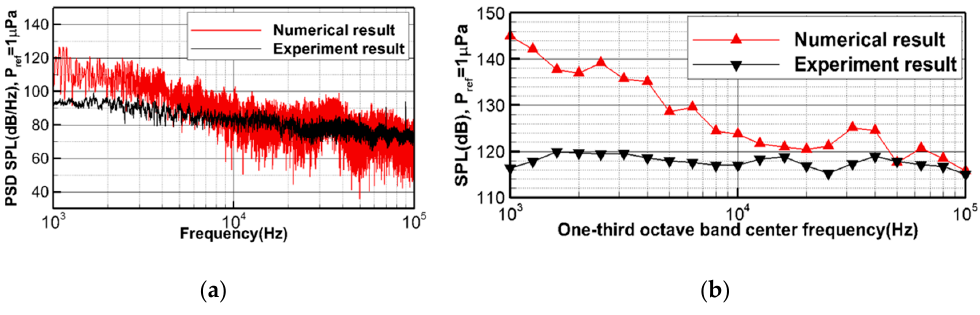
Figure 23. Comparison of acoustic pressure between numerical and experimental results; ( a ) power spectral density (PSD); ( b ) band spectrum.